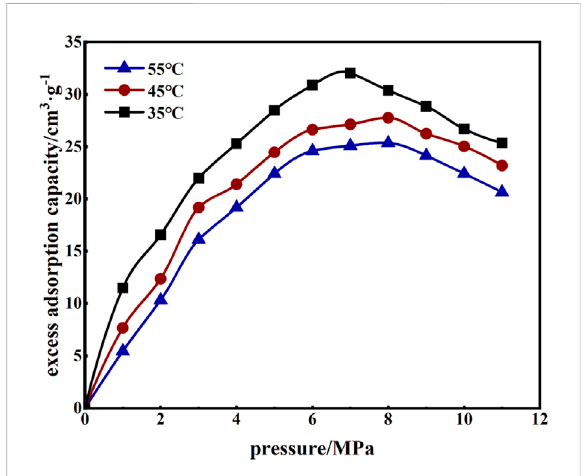
FIGURE 6 Change curves of excess CO 2 adsorption with pore